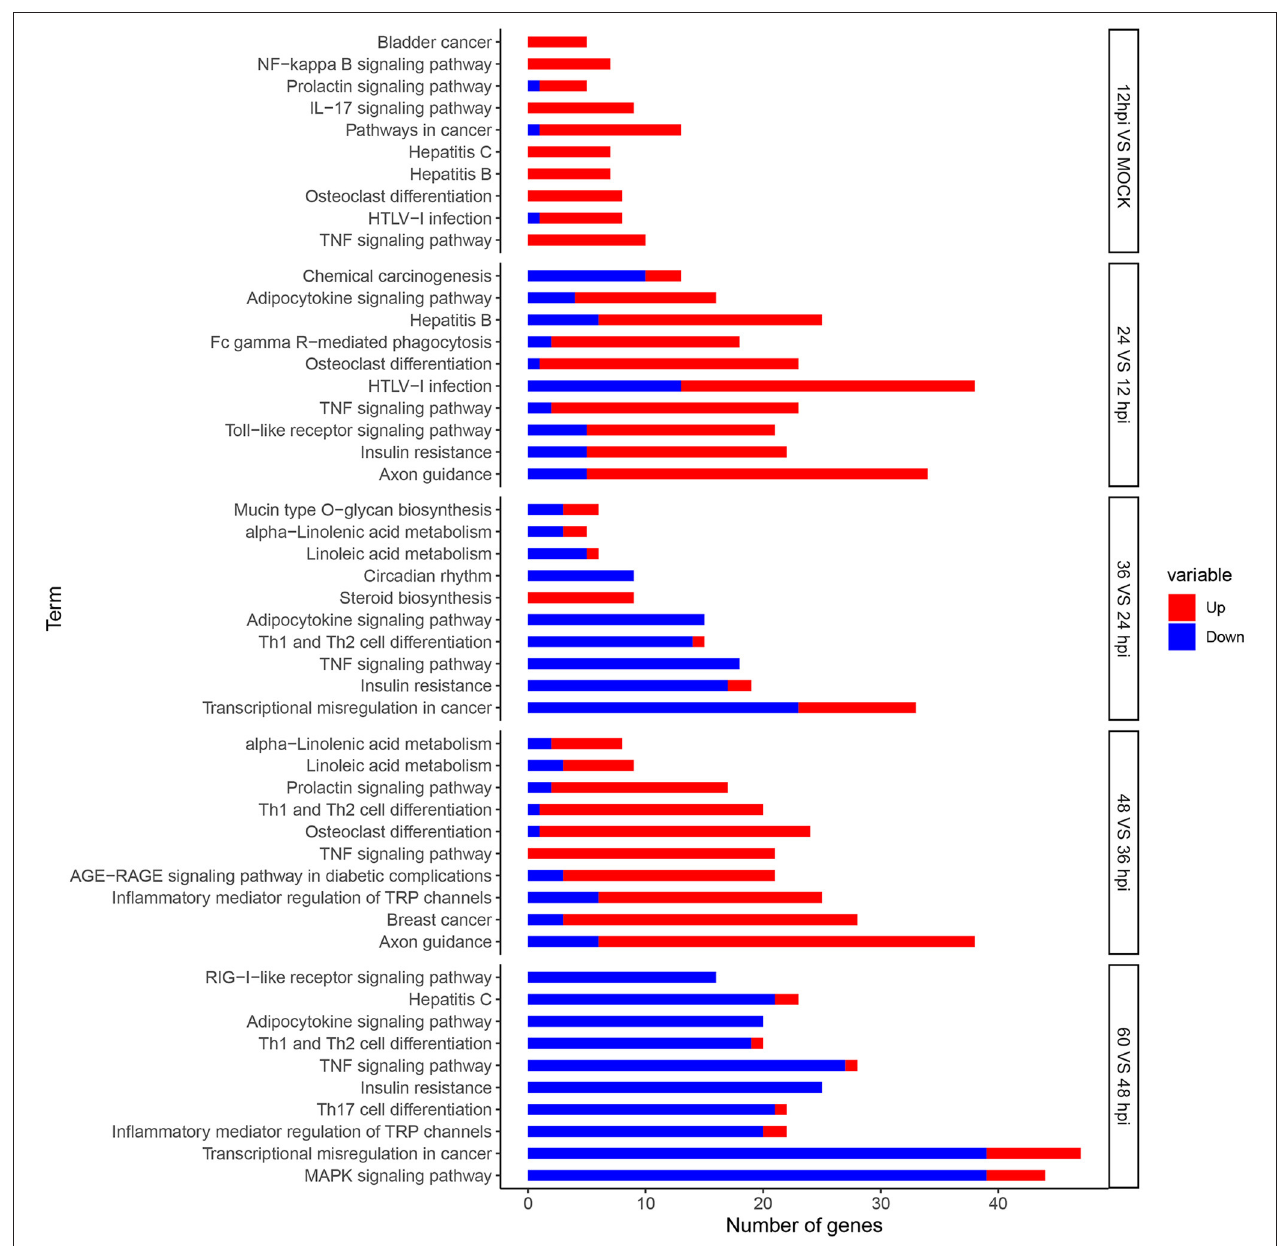
FIGURE 4 | Analysis of DEGs using Kyoto Encyclopedia of Genes and Genomes (KEGG) terms. Top 10 KEGG pathways significantly ( P -value < 0.05) enriched in biological processes at five time points. The x-axis represents the number of genes, and the y-axis represents functional groups. Red and blue portions of the bar represent the number of upregulated and downregulated genes,